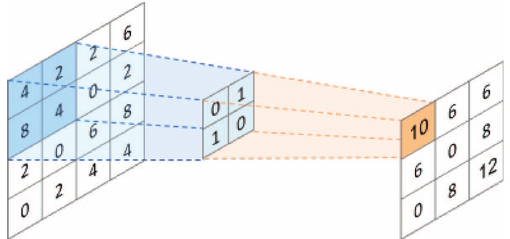
Figure 1: Convolution Operation.